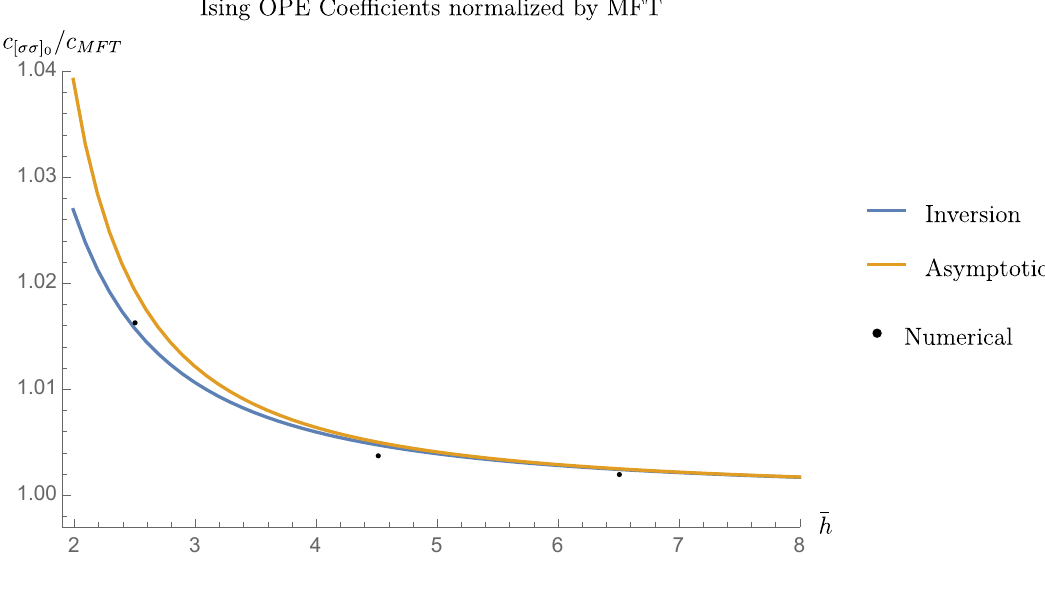
Figure 2 . OPE coefficients f in the Ising CFT. Numerical data is taken from [14] and the σσ [ σσ ] 0 OPE coefficients are normalized by dividing by the mean field theory OPE